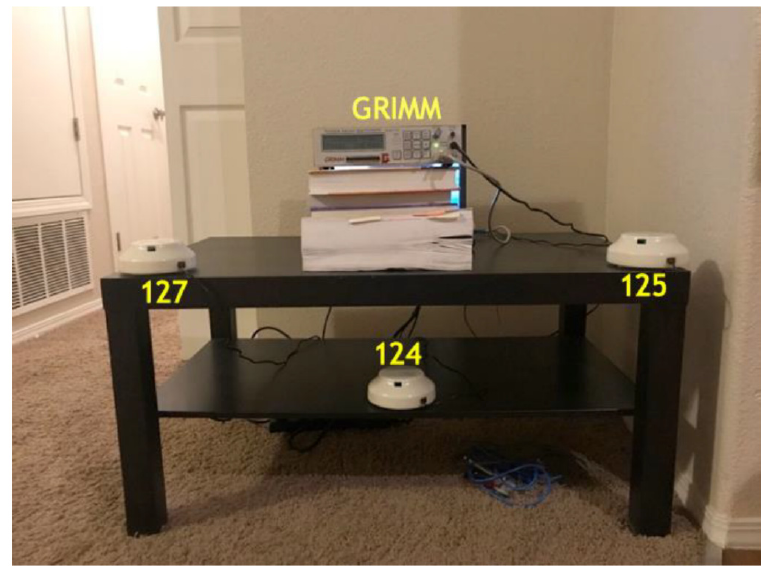
Figure 1. Photograph of AirU and GRIMM configuration for comparison in residential home. The GRIMM (labeled) was placed in an elevated position and the three AirUs (124, 125, 127) were triangulated around it.